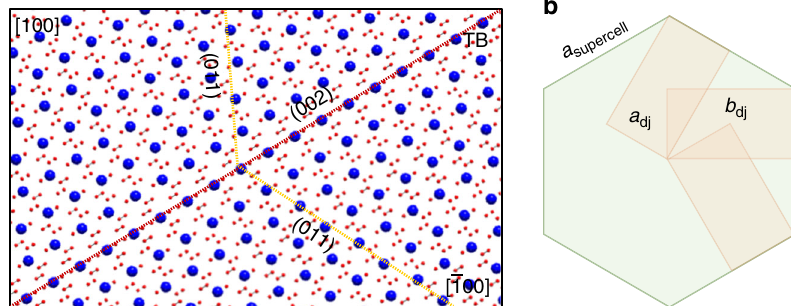
Fig. 5 Origin of twinning. a Schematic of twinning in a high chalcocite lattice (S 2 − shown in blue; Cu + in red). The twin boundary (TB) is denoted by the dotted red line and key crystallographic planes are indicated by dotted yellow lines. b Symmetry relationship of a unit cell of near-orthorhombic djurleite (camel tetragon) to its supercell (green hexagon) of pseudo-hexagonal symmetry 41 . a dj and b dj are lattice constants of the djurleite unit cell, while a supercell is the lattice constant of the supercell in the basal plane. The symmetry relationship is possible because a dj ~ √ 3 b